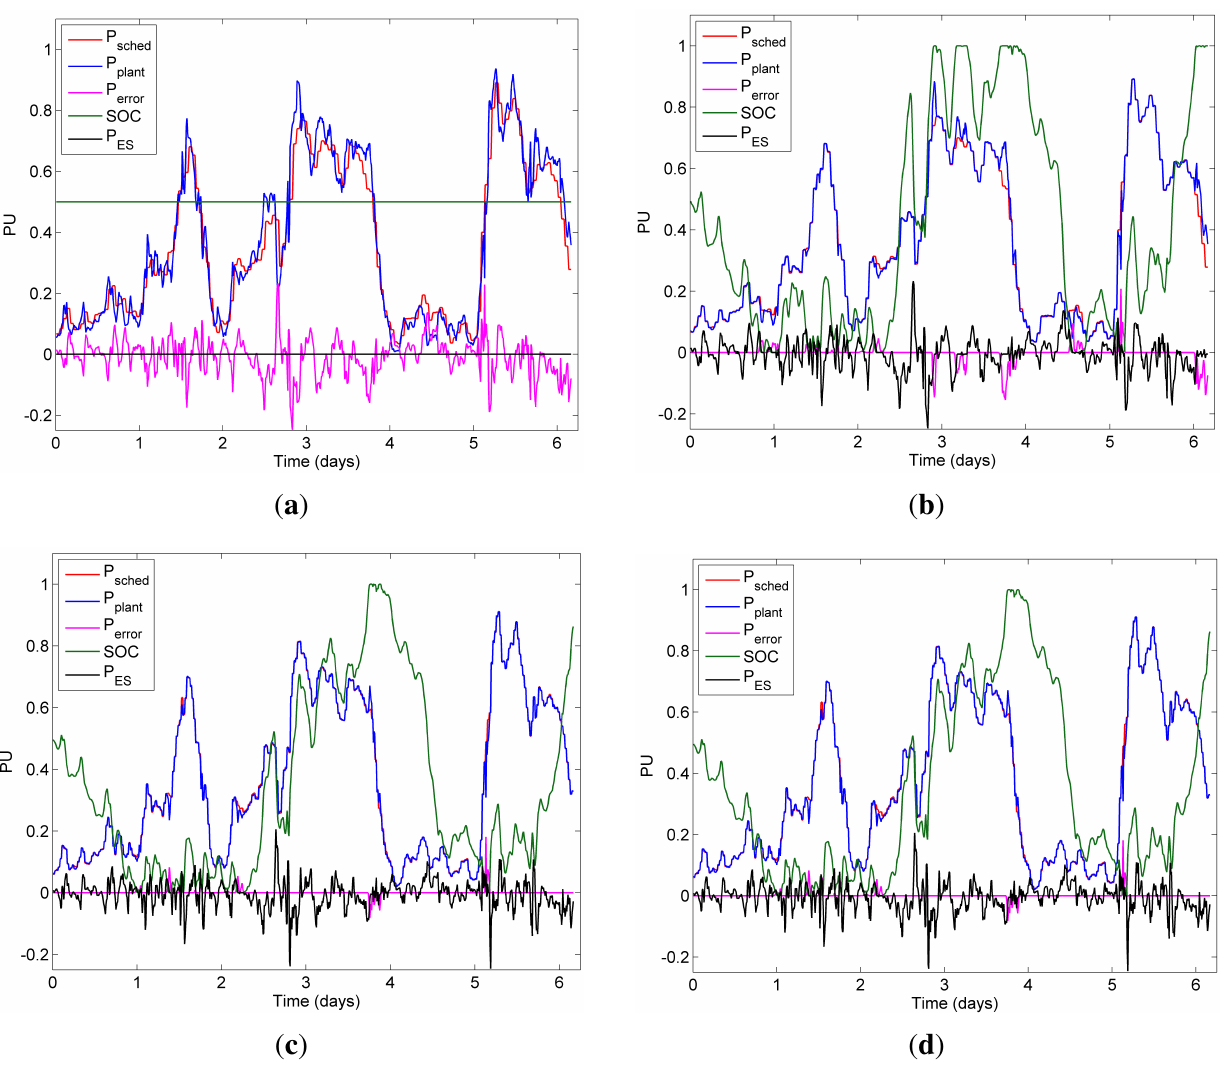
Simulation results for: ( a ) Case 1 with energy storage inactive and 60